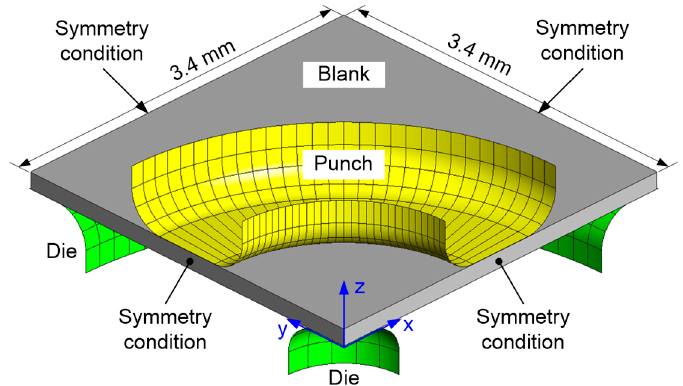
Figure 16. Finite element model adopted to simulate the stamping of the U-bend channel section (revolved tool geometry).